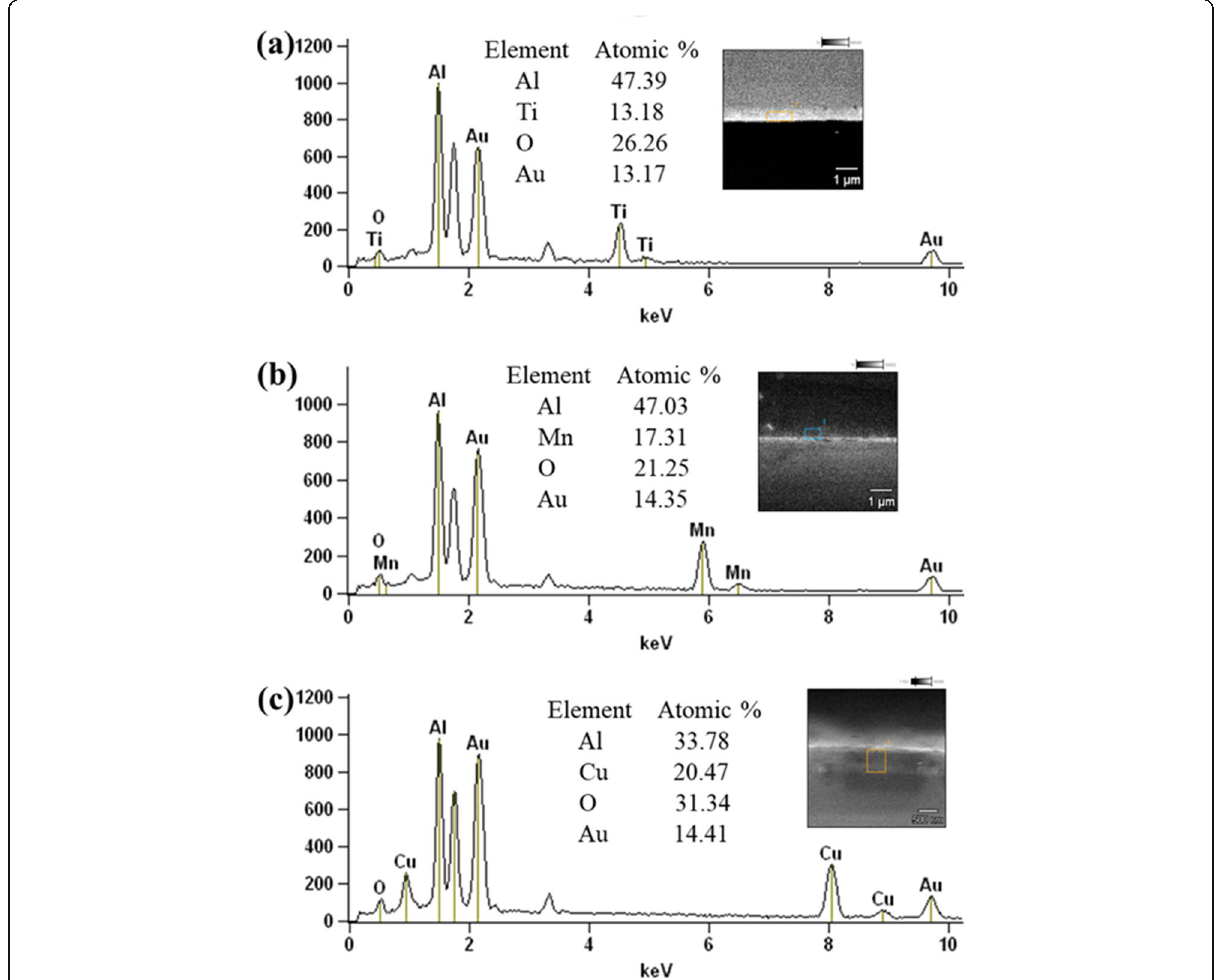
Fig. 3 EDS patterns on the RMFs a TiO 2 /Al, b MnO 2 /Al, and c